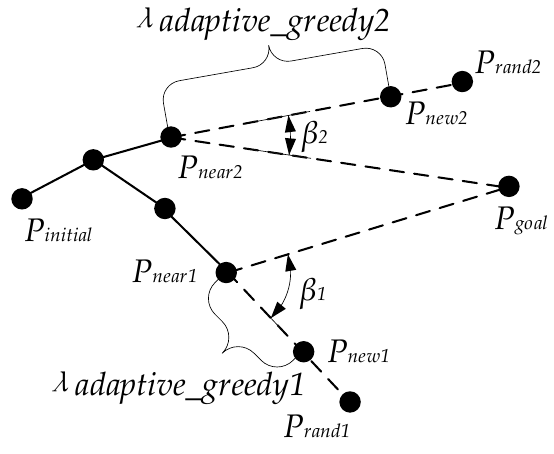
Figure 8. Adaptive greedy step size.